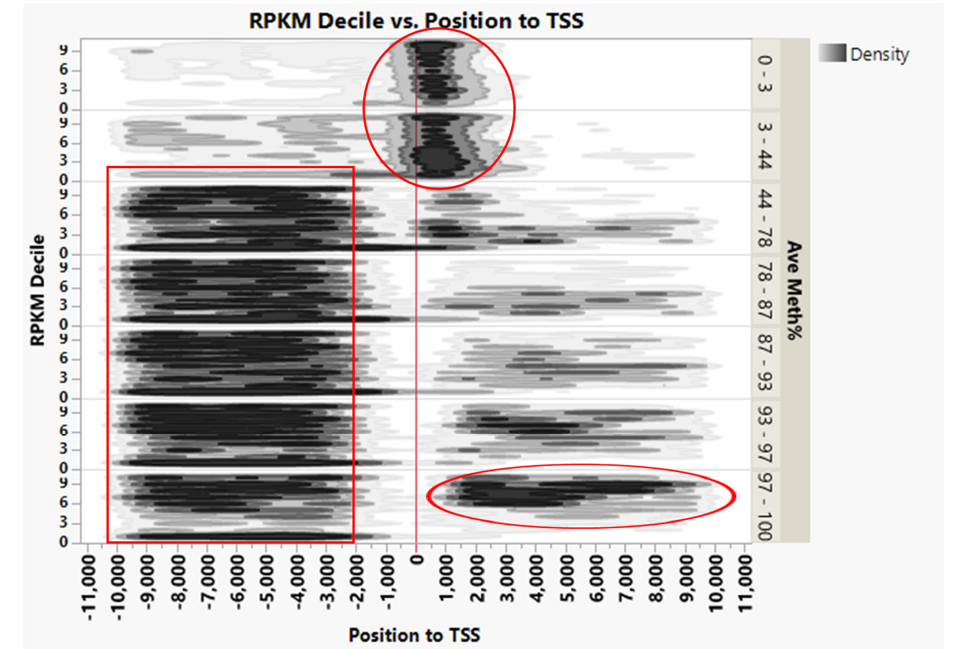
Figure 8. Density of CGIs in various genic regions and their relation to gene expression. Hypomethylation (0–44%) of CGIs was observed within 0 to +2 kb of TSS, regardless of gene expression level (top circle) and an increased percentage of the hypermethylated CGIs (>97%) in the highly expressed genes (right circle). Most CGIs at − 2 to − 10 upstream of genes are methylated (>44%), regardless of gene expression.